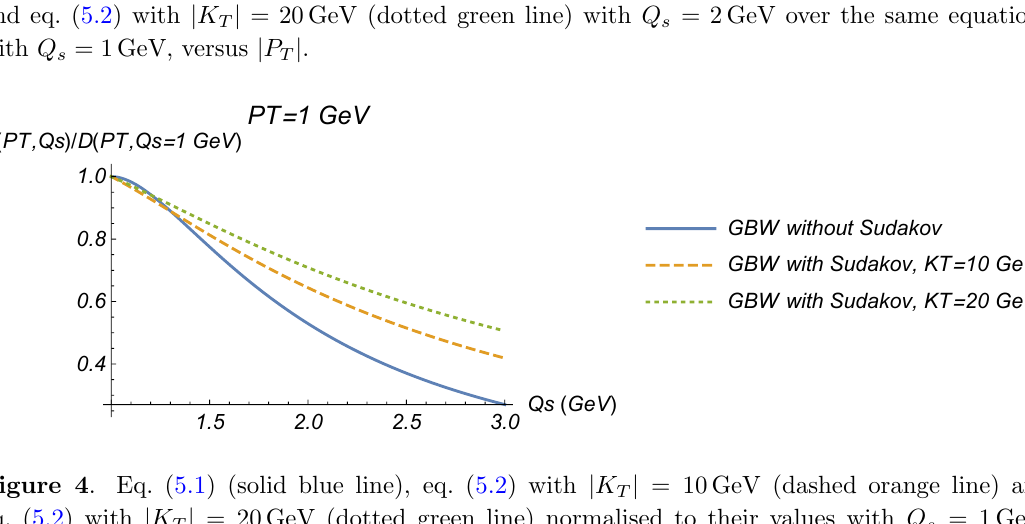
K T = 10 GeV (dashed orange line) and j j